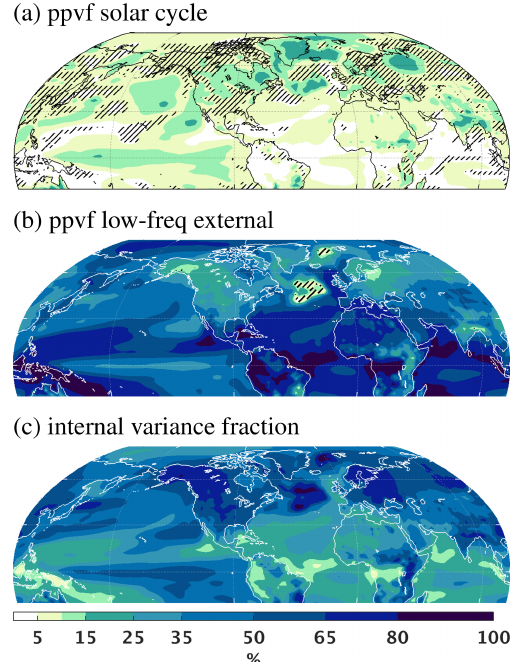
Figure 1. Decadal potential predictability due to the solar cycle, other external forcings and internal climate variability. Potential predictability variance fraction (ppvf; explained variance) with re- spect to the DJF 8-year averaged surface air temperature associ- ated with (a) the 11-year solar cycle, (b) all other external forcings (anthropogenic forcings, volcanic aerosols, and solar-induced low- frequency variability), and (c) remaining variance fraction due to internal climate variability. Statistically insignificant regions ( p > 0 . 05) in (a) and (b) are hatched. Panel (b) exhibits masked areas solely over a few grid points in the North Atlantic because “ppvf low-frequency external” for 2m temperature is significant almost globally. See “Methods” section for more details on the ppvf calcu- lation and statistical significance